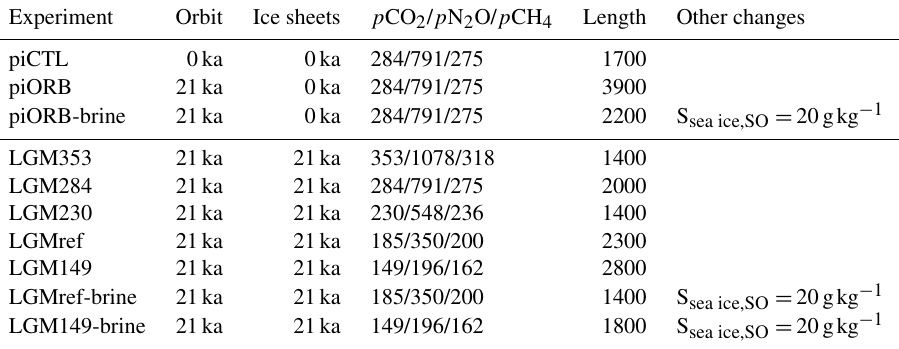
Table 1. List of experiments and the respective forcing configurations. p CO 2 is given in ppm, p N 2 O and p CH 4 in ppb. The length of the simulations is given in years.